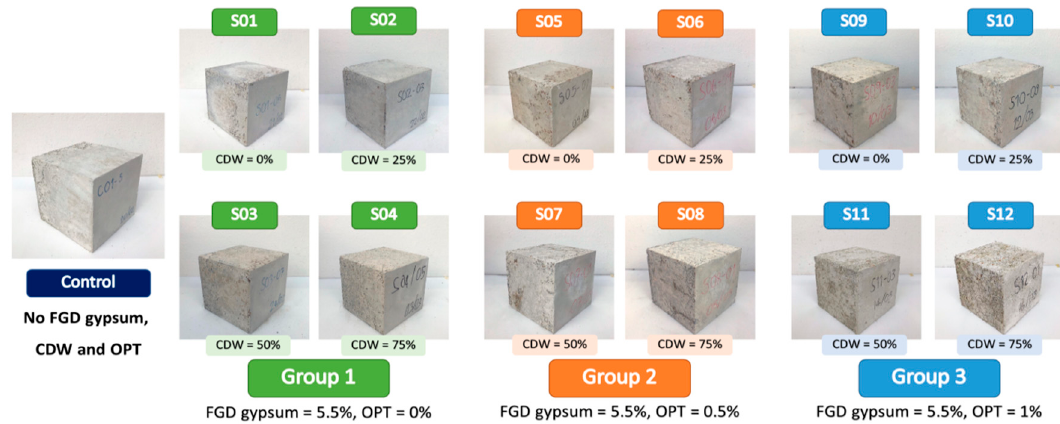
Figure 4. The appearance of the concrete bricks.